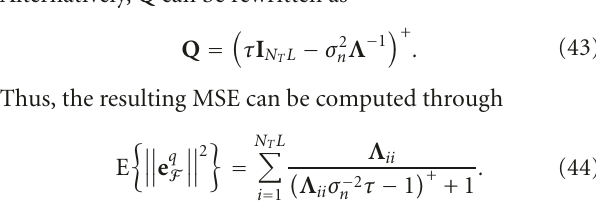
Table 2: Transmission structure of training sequences ( N T =